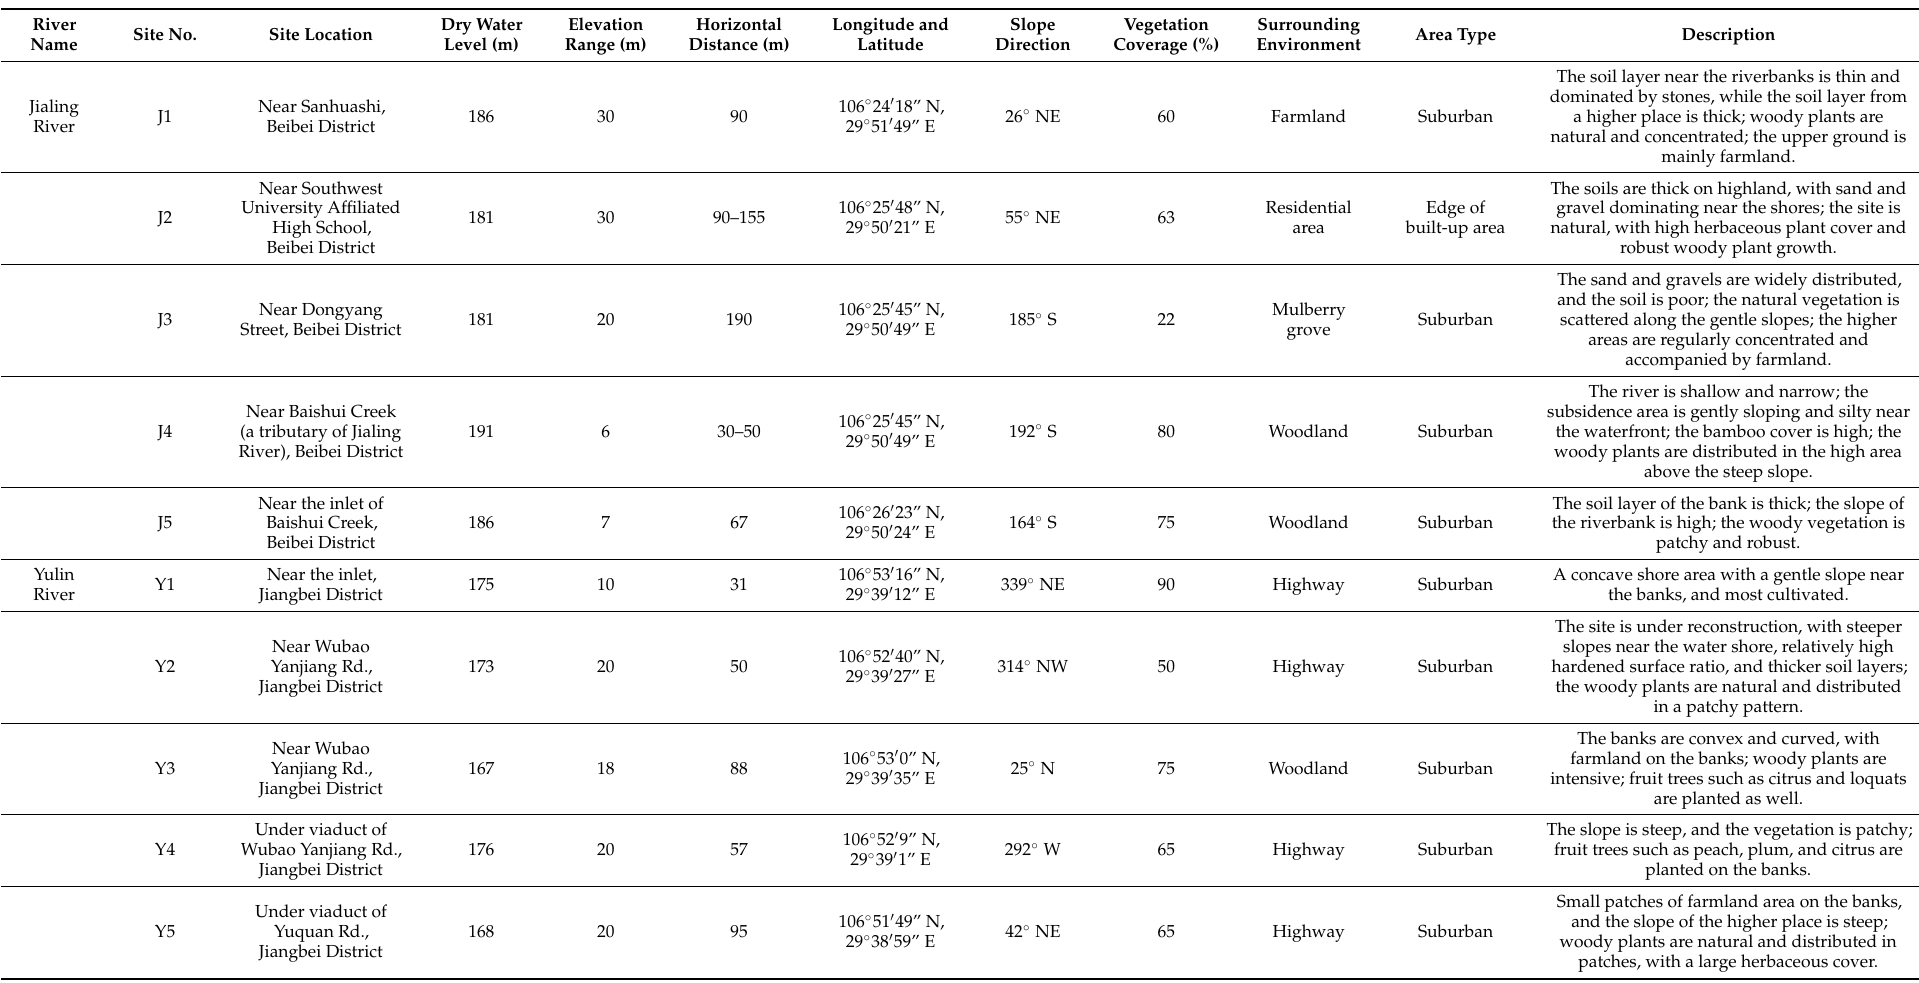
Table 1. The locations’ information of the riparian sample sites of the study area, Chongqing, China.